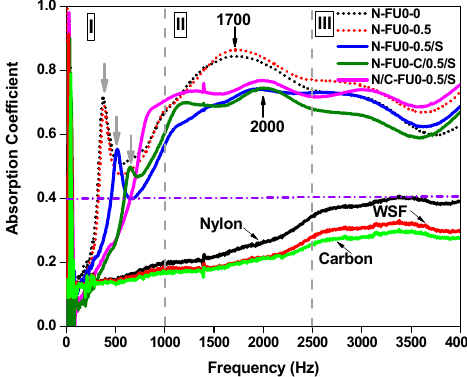
Figure 5. Sound absorption coefficient of MFRCs.